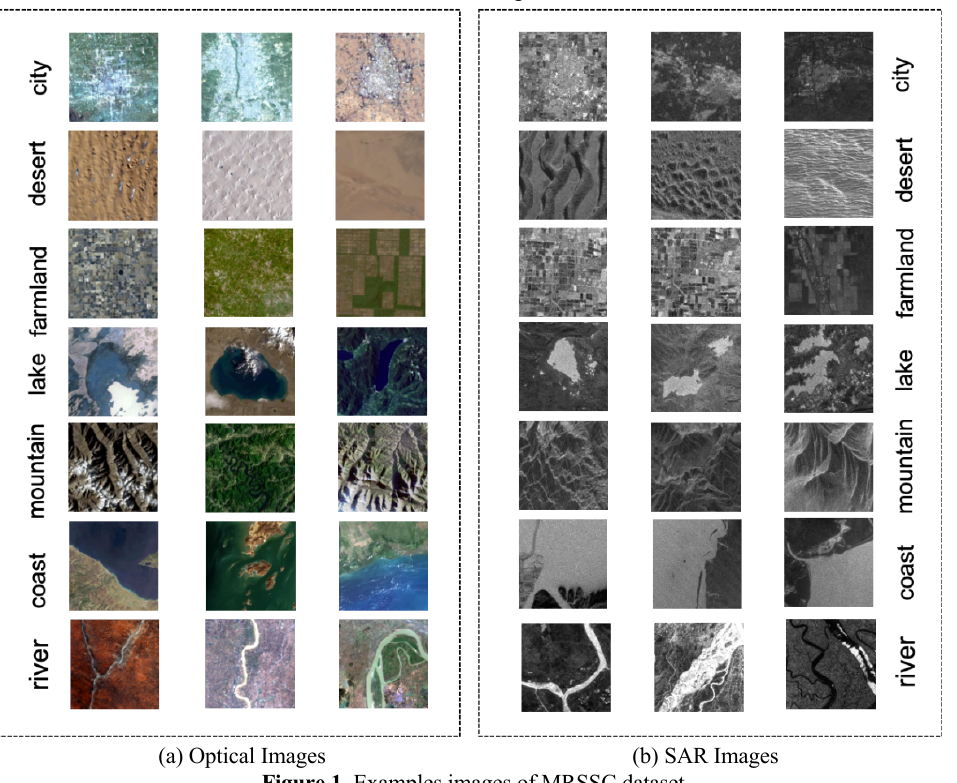
Figure 1 . Examples images of MRSSC